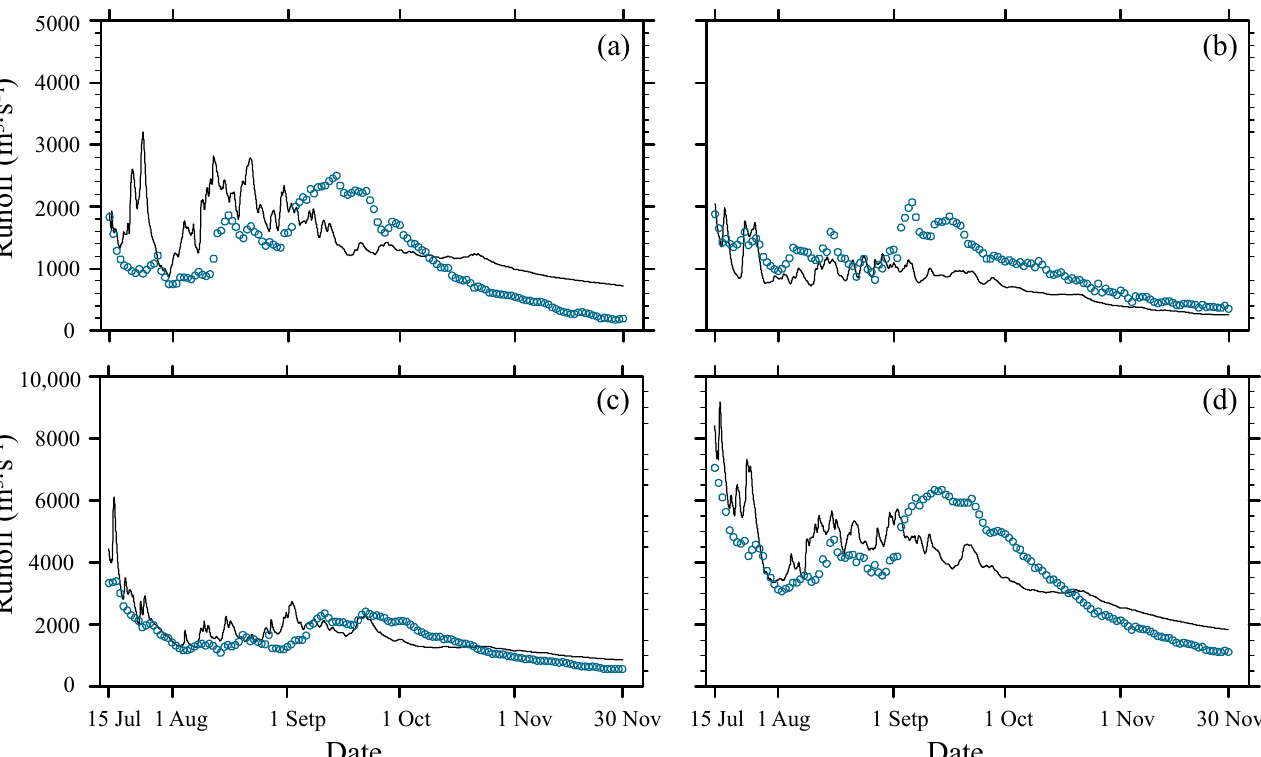
Figure 3. Time series of observed and simulated (uncoupled WRF-Hydro) discharge of ( a ) Zhimenda station; ( b ) Changdu station; ( c ) Tangnag station; ( d ) amount of three stations.